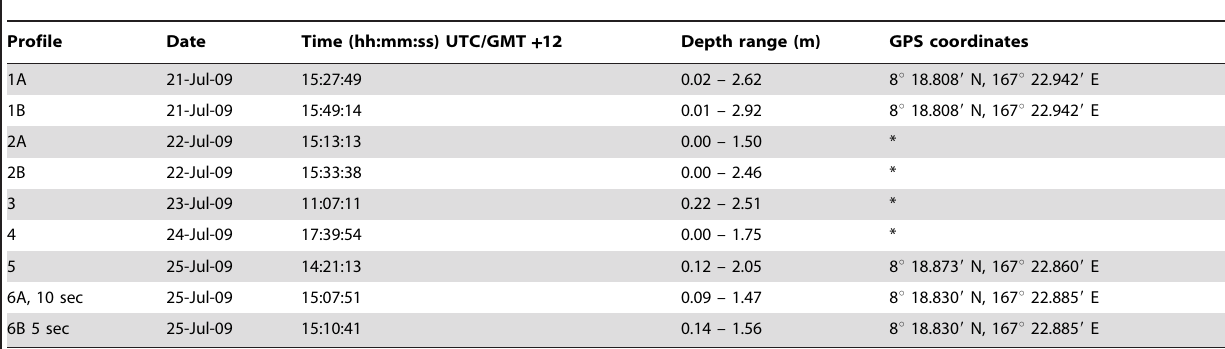
Table 3. Water Sample